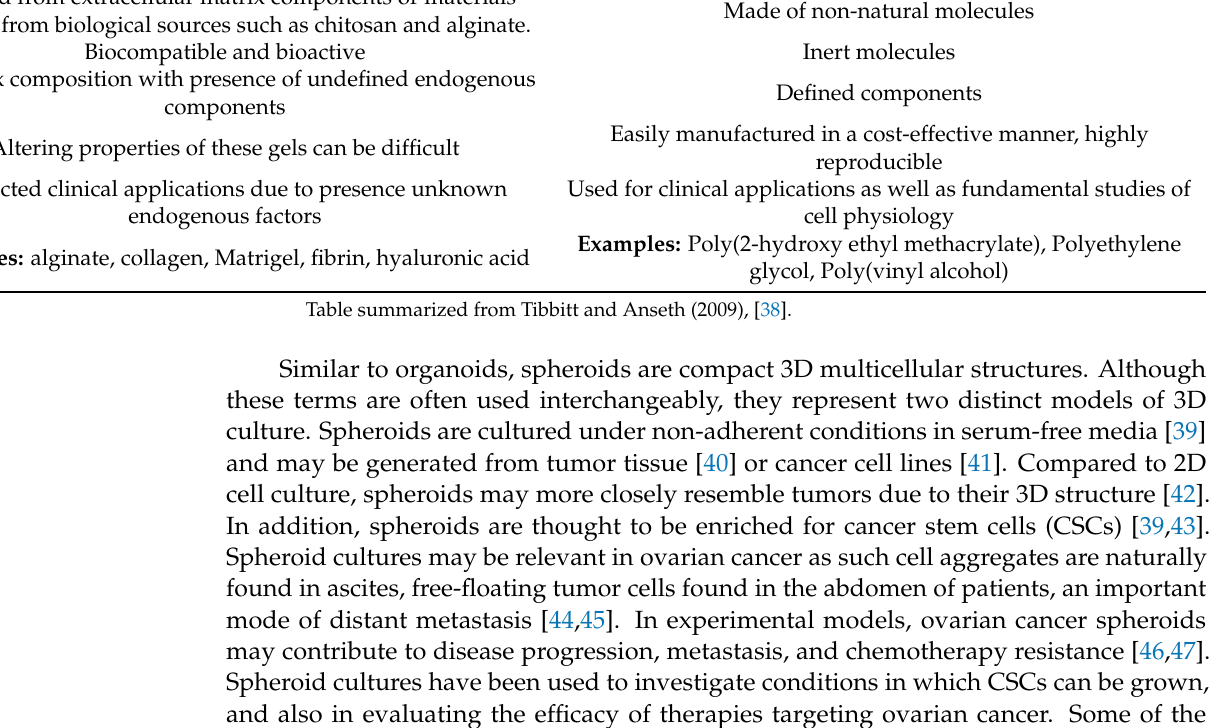
Table 3. Types of extracellular matrix (ECM) gels used in 3D organoid culture. Natural ECM Gels Synthetic ECM Gels